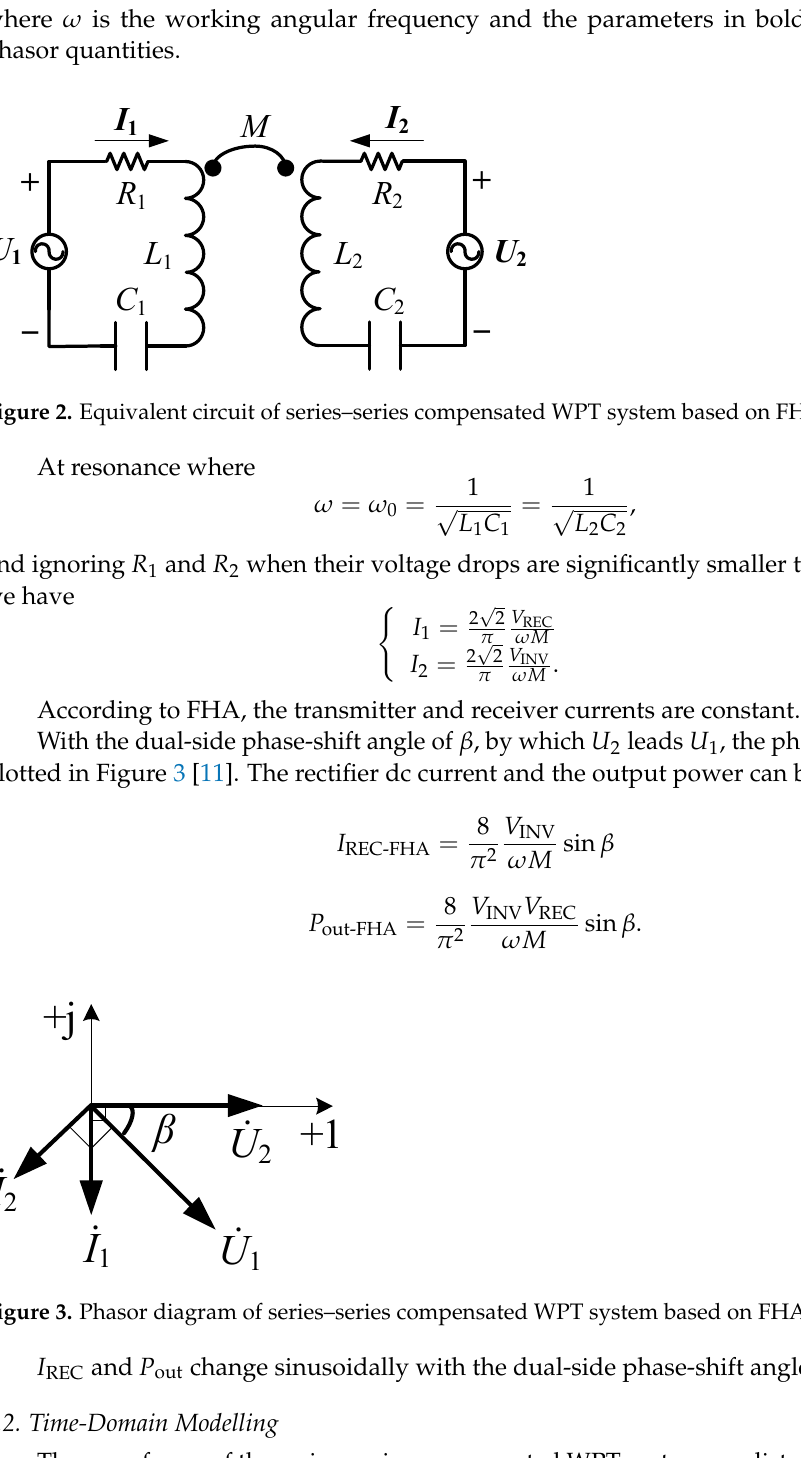
where ω is the working angular frequency and the parameters in bold represent the